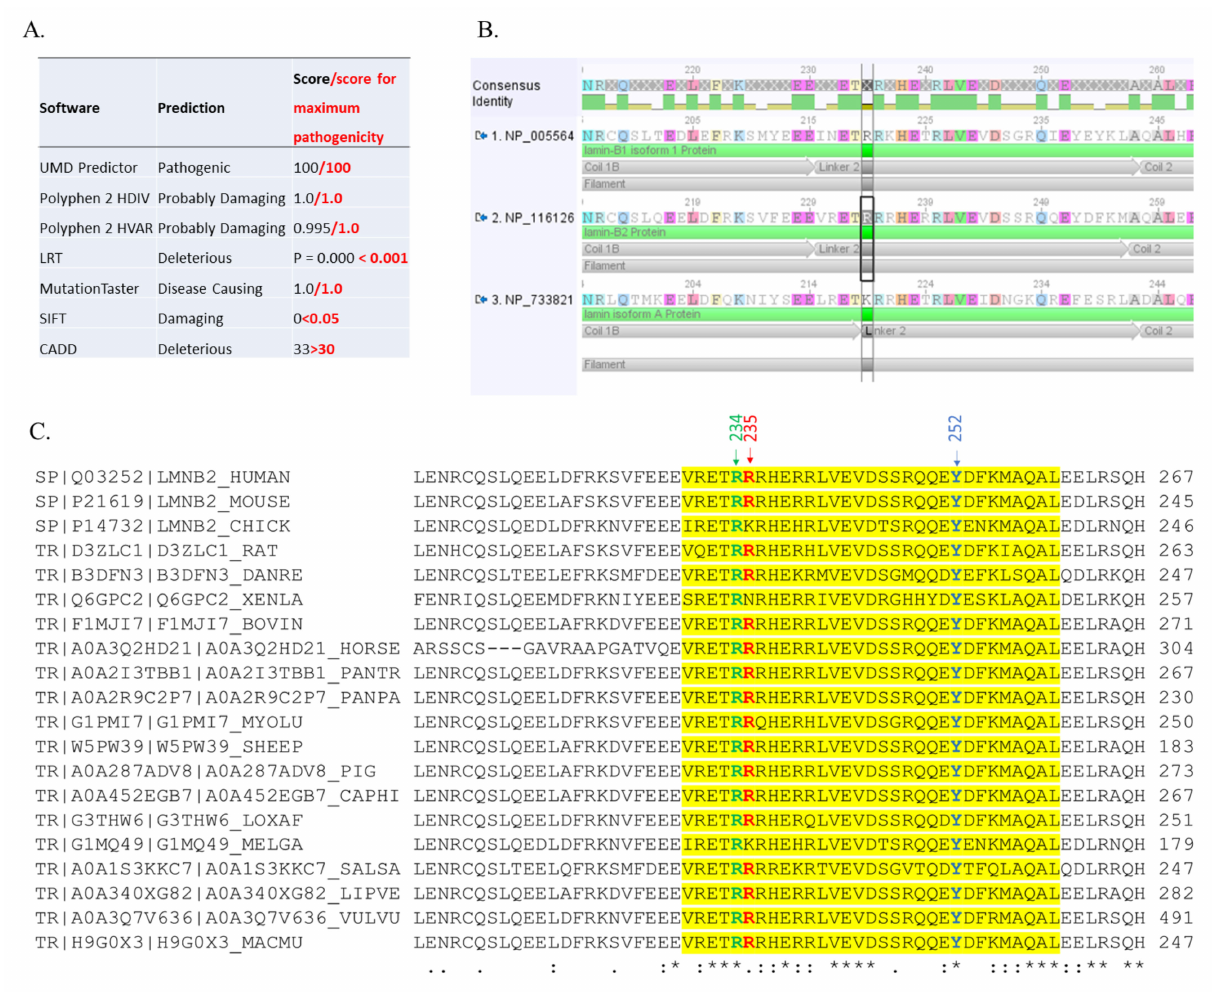
Figure 2. Bioinformatic analysis of the mutation. ( A ) Pathogenicity prediction of the mutation of LMNB2 p.(Arg234Trp) by a set of bioinformatics tools. ( B ) The position of the mutation is located (framed) within the linker 2 of the highly conserved rod domain. The homologous regions from Lamin B1, B2, and A were aligned with Geneious 4.8.5. ( C ) Multiple sequence alignment on CLUSTAL O